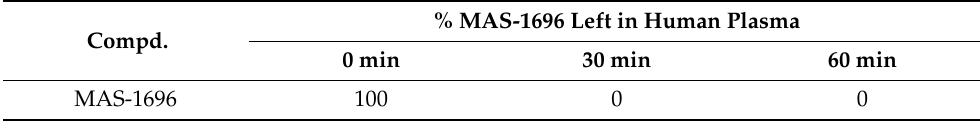
% MAS-1696 Left in Human